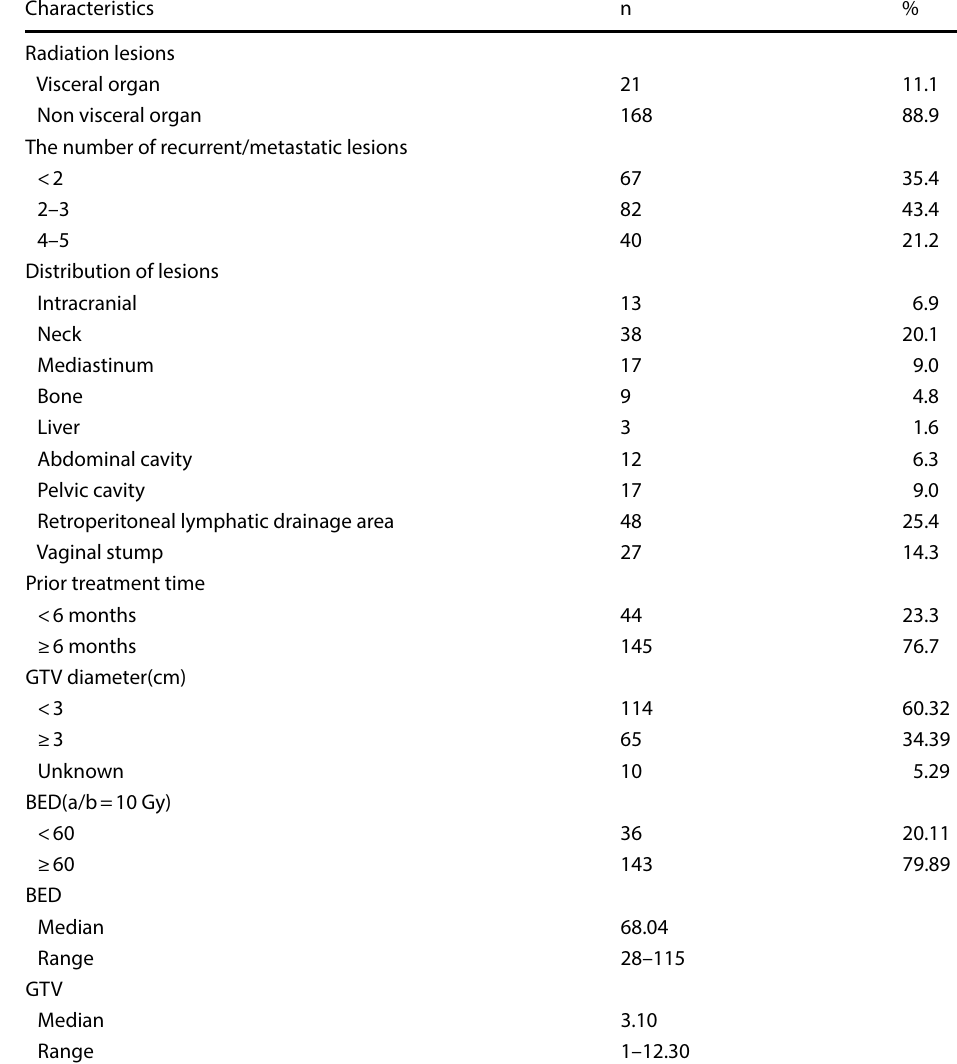
Table 2 Characteristics of